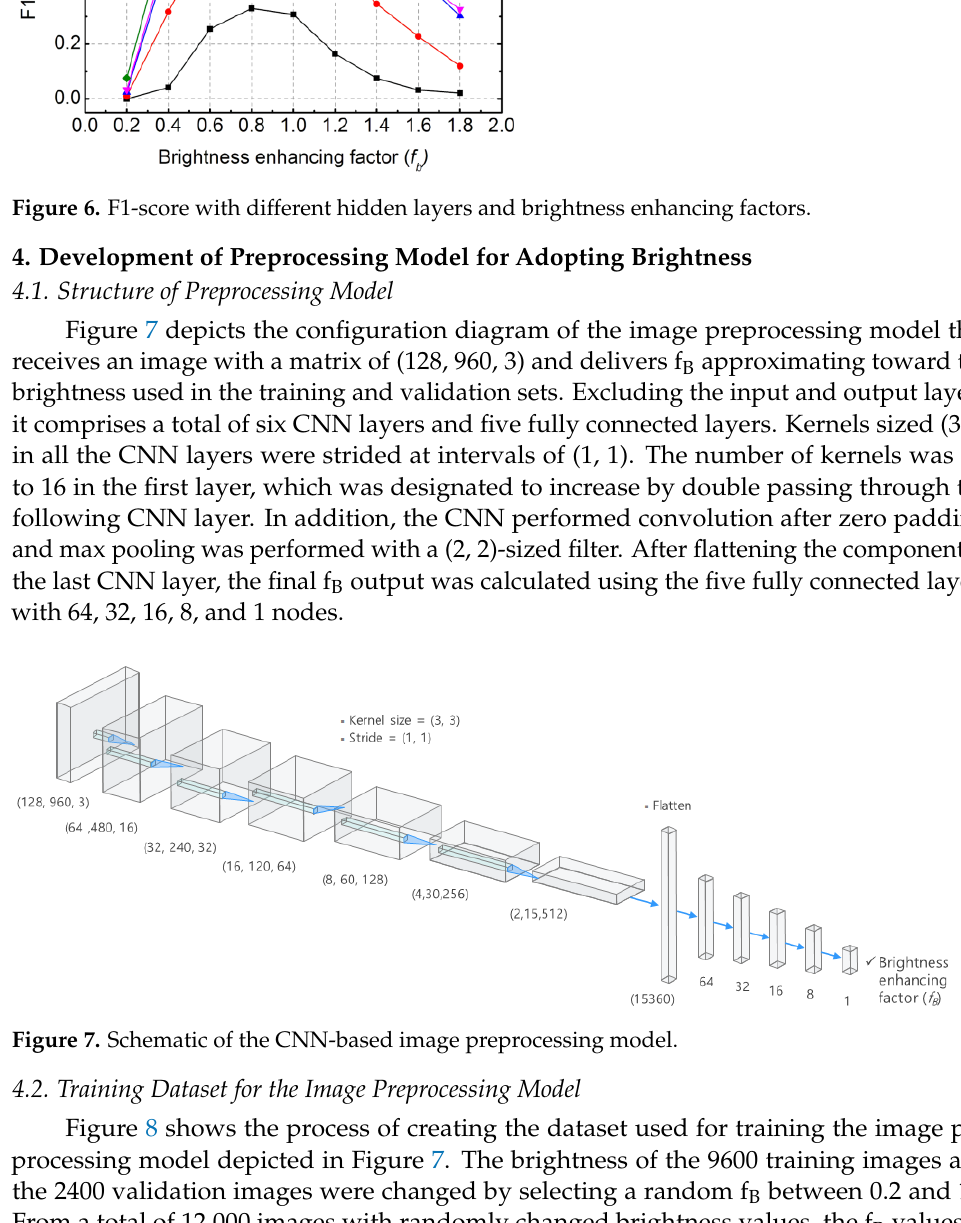
Figure 5. F1-score with different hidden layers and the number of model training images set.